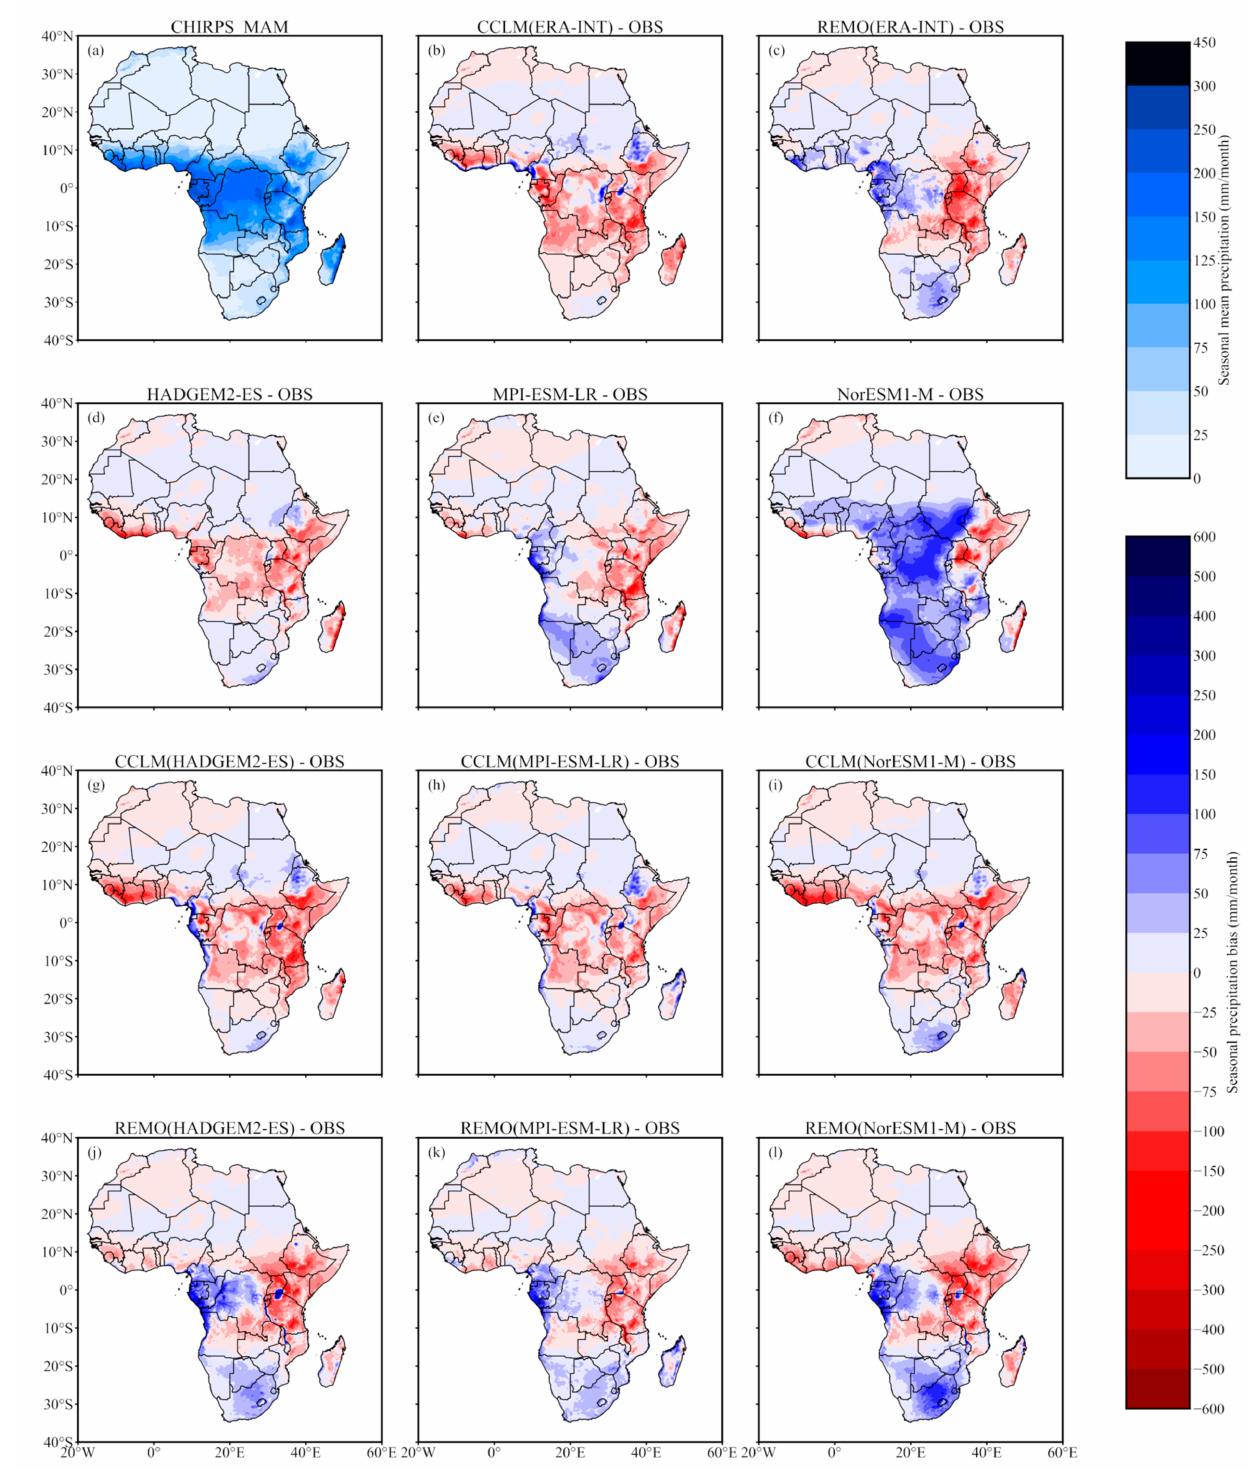
Figure 3. Bias of monthly precipitation in MAM, compared to CHIRPS, for GCMs, CCLM, and REMO: ( a ) CHIRPS ( b ) CCLM (ERA–INT)–CHIRPS, ( c ) REMO (ERA-INT)-CHIRPS, ( d ) HadGEM2-ES-CHIRPS, ( e ) MPI-ESM-LR-CHIRPS, ( f ) NorESM1- M-CHIRPS, ( g ) CCLM (HadGEM2–ES)-CHIRPS, ( h ) CCLM (MPI–ESM–LR)-CHIRPS, ( i ) CCLM (NorESM1–M)–CHIRPS, ( j ) REMO (HadGEM2–ES)-CHIRPS, ( k ) REMO (MPI–ESM–LR)–CHIRPS, ( l ) REMO